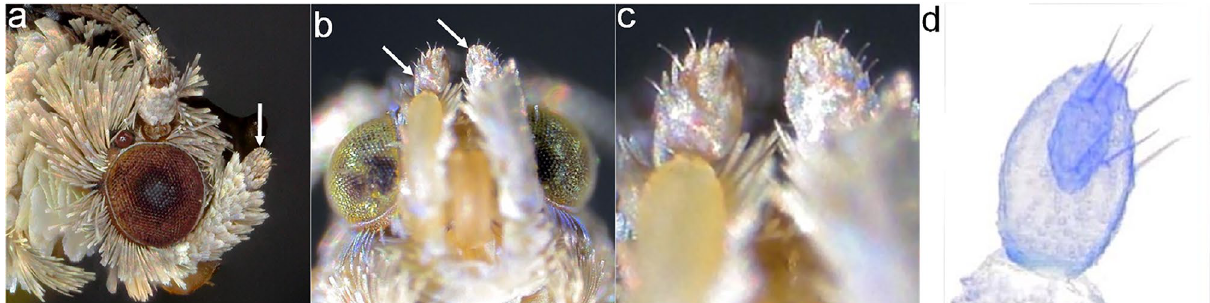
Figure 1. Labial palps of a female G. molesta . ( a ) Lateral view, ( b ) ventral view, scales have been partially removed from the right palp, ( c ) close up of "b" showing sensilla chaetica clearly protruding among the scales from the third segment, ( d ) third segment digested with KOH and stained with gencian violet to show the labial pit organ (elongated dark sac inside the palp) and the sensilla chaetica on the surface. White arrows in panels “( a )” and “( b )” indicate the apical segment of labial palp.